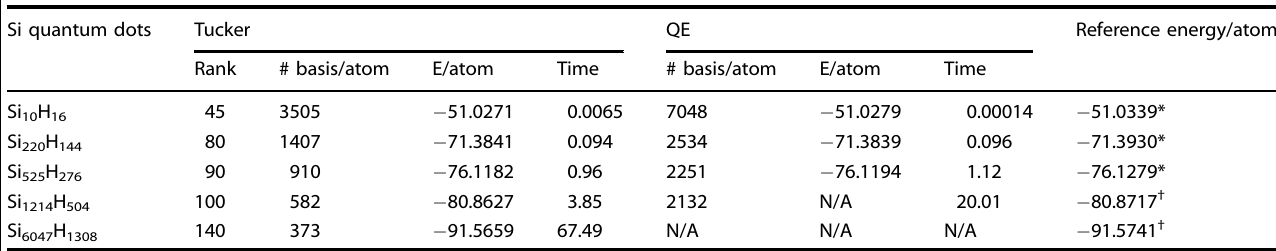
Table 2. Comparison of the computational performance for silicon quantum